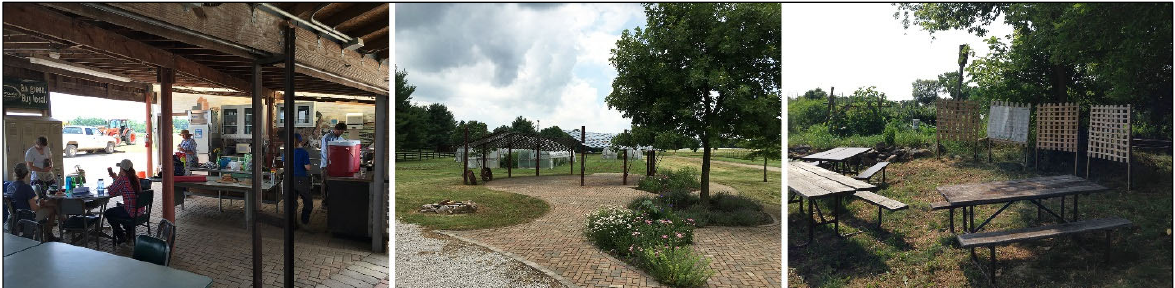
Figure 4. Indoor Primary Gathering Area at Farm Hub (Left); Outdoor Event-Sized Gathering Area (Middle); Outdoor Primary Gathering Area